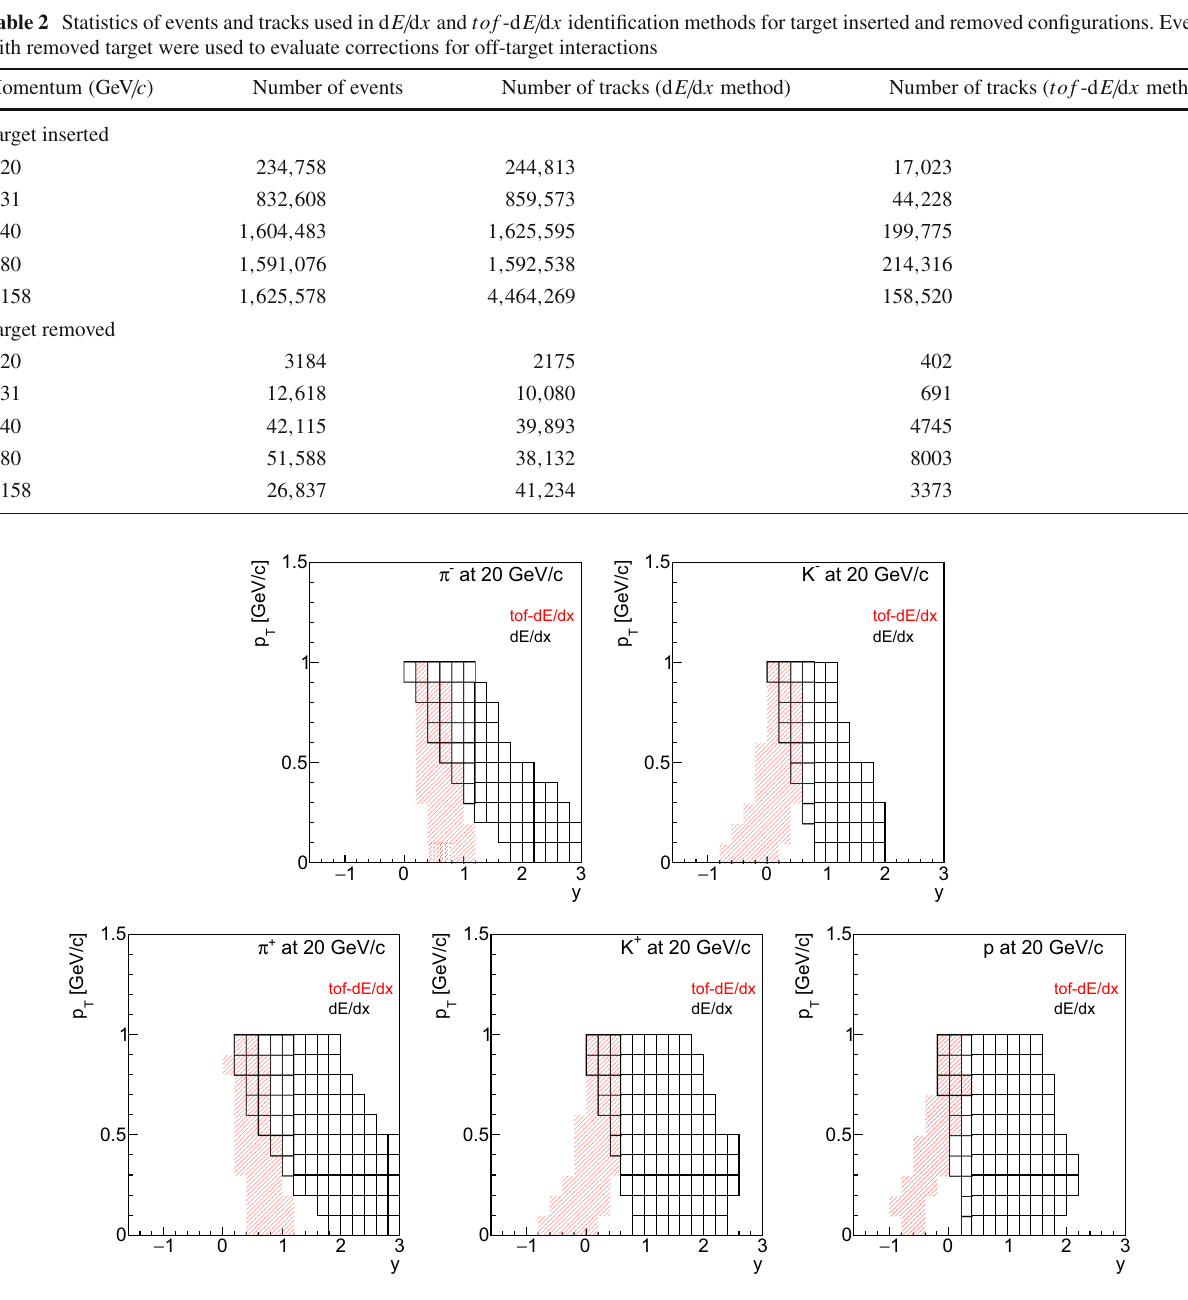
Fig. 2 Acceptance of the tof -d E / d x and d E / d x methods for identification of pions, kaons and protons in p + p interactions at 20 GeV / c